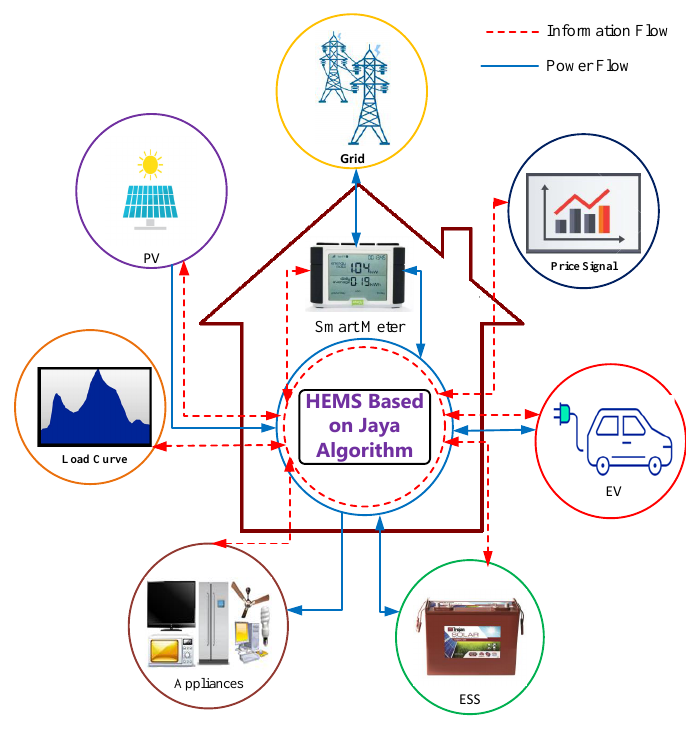
Figure 1. Configuration of smart